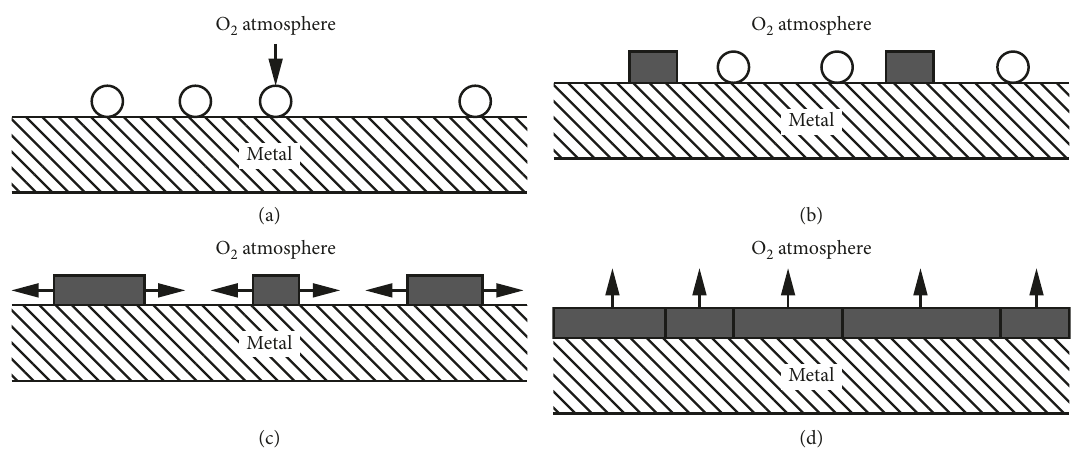
Figure 14: Model of oxide scale formation on the pure metal surface. (a) Oxygen absorption at the surface; (b) formation of nuclei; (c) lateral growth of nuclei; (d) the growth of the oxide scale [152].